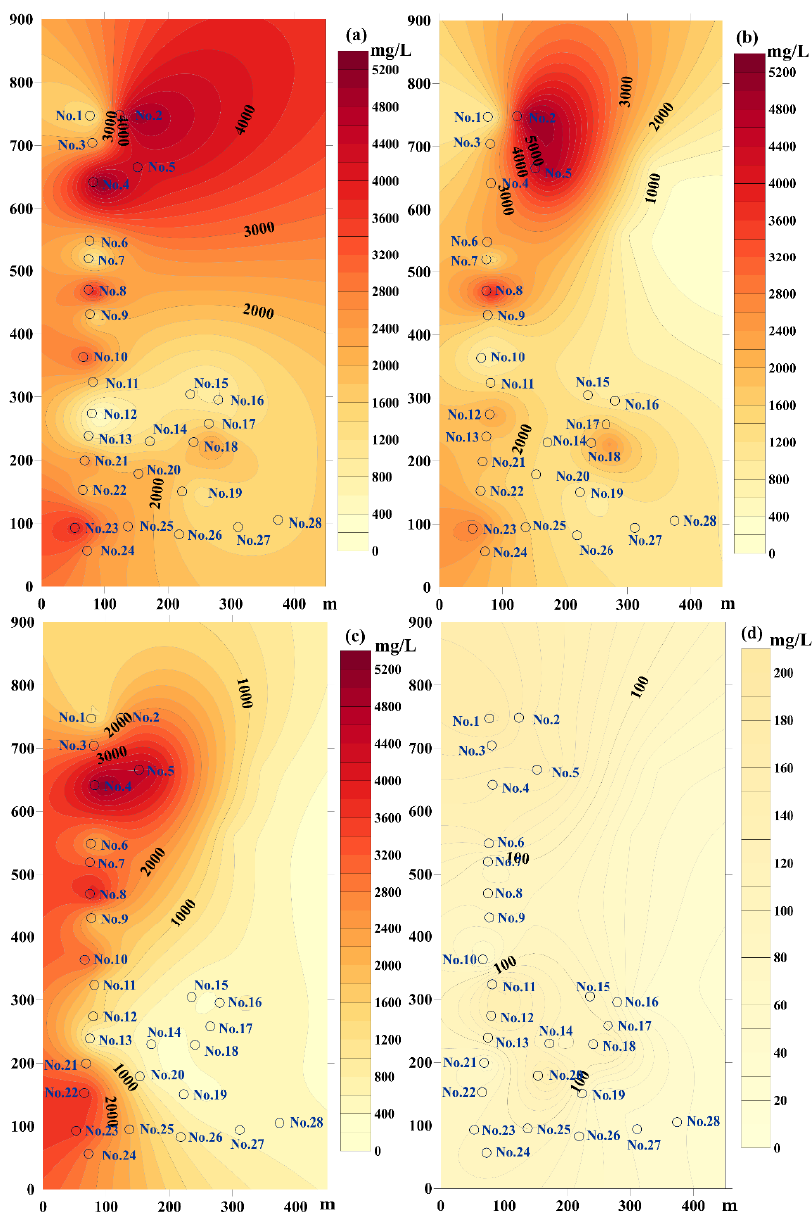
Figure 8. Sulfate concentration distributions after treatment for 30 d ( a ), 60 d ( b ), 90 d ( c ), and 120 d ( d ).